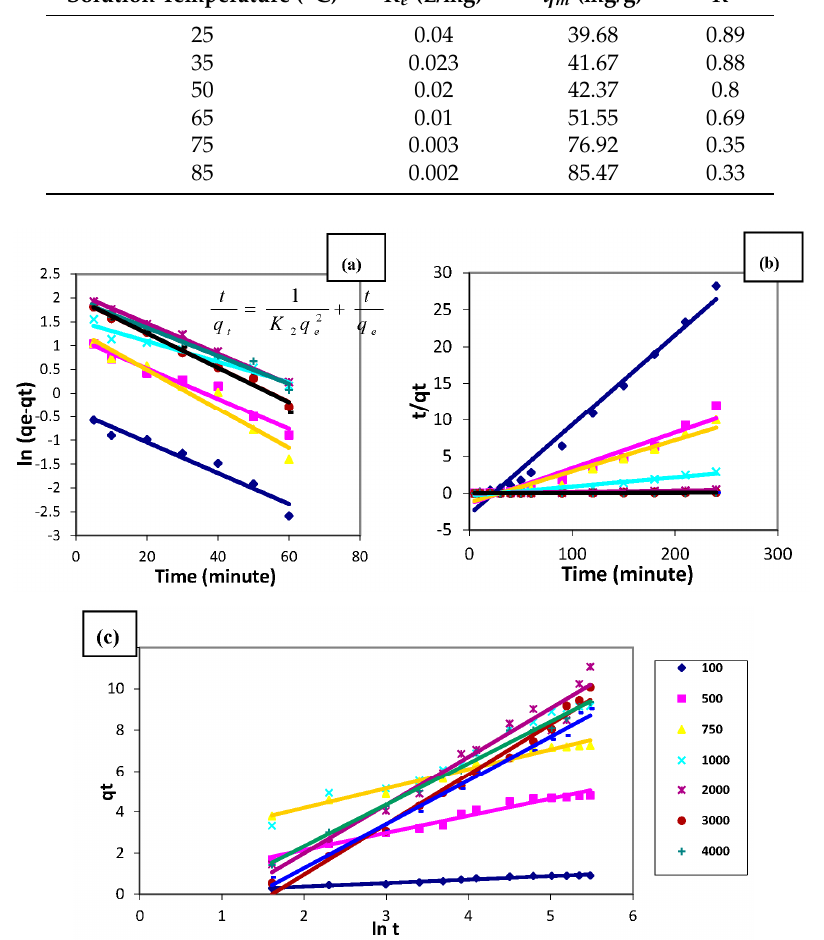
Figure 16. Kinetic models for the copper sorption process (solution temperature = 25 °C; amount of MANSG = 0.25 g; agitation speed = 200 rpm; solution volume = 25 mL; pH = 7): ( a ) pseudo-first-order rate model; ( b ) pseudo-second-order rate model; ( c ) the simple Elovich model.